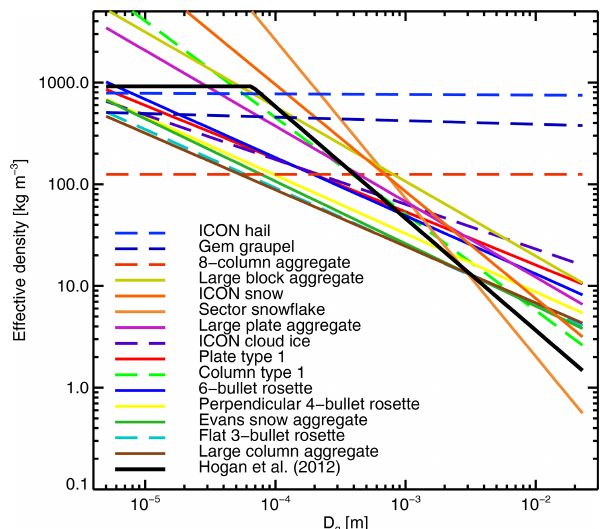
Figure 3. Effective density ρ e implied by the mass–size relations of the particles from the ARTS database, as a function of geo- metric particle size (maximum dimension D g ). Also shown is the Hogan et al. (2012, their Eq. 4) restatement of the Brown and Fran- cis (1995) mass–size relation in SI units and as a function of D g . The ARTS mass–size relations are represented across the whole size range, even if non-physical densities may be generated, since that is how they are used in Eq. (10) (later). The legend is ordered by the effective density at 1 × 10 − 3 m (with the exception of the line corresponding to Hogan et al., 2012). Figure 11 of Eriksson et al. (2018) is similar but is based on the reported particle masses, rather than the mass–size